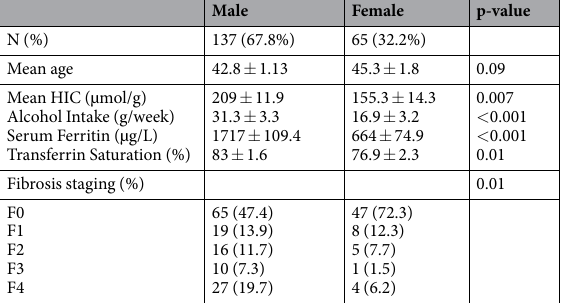
Table 1. Baseline patient characteristics of HH subjects. Data presented as mean ± standard error of mean or proportions. HIC, hepatic iron concentration.